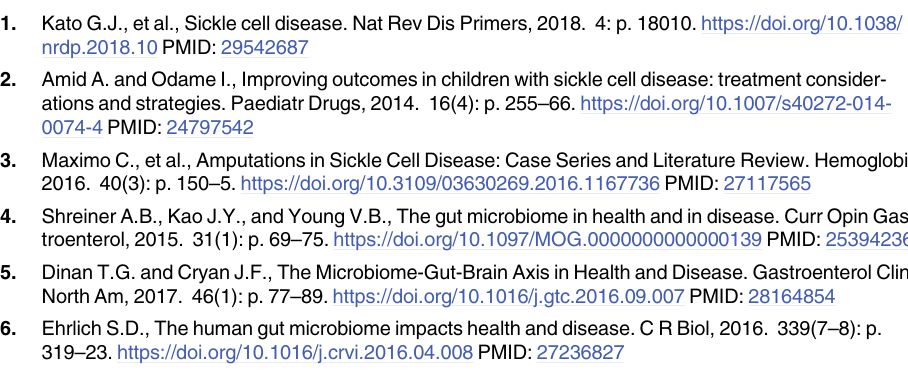
S1 Fig. Rarefaction curves were established for each set of samples. For all samples, the depth of sequencing and number of reads were adequate as all curves reached OTU detection